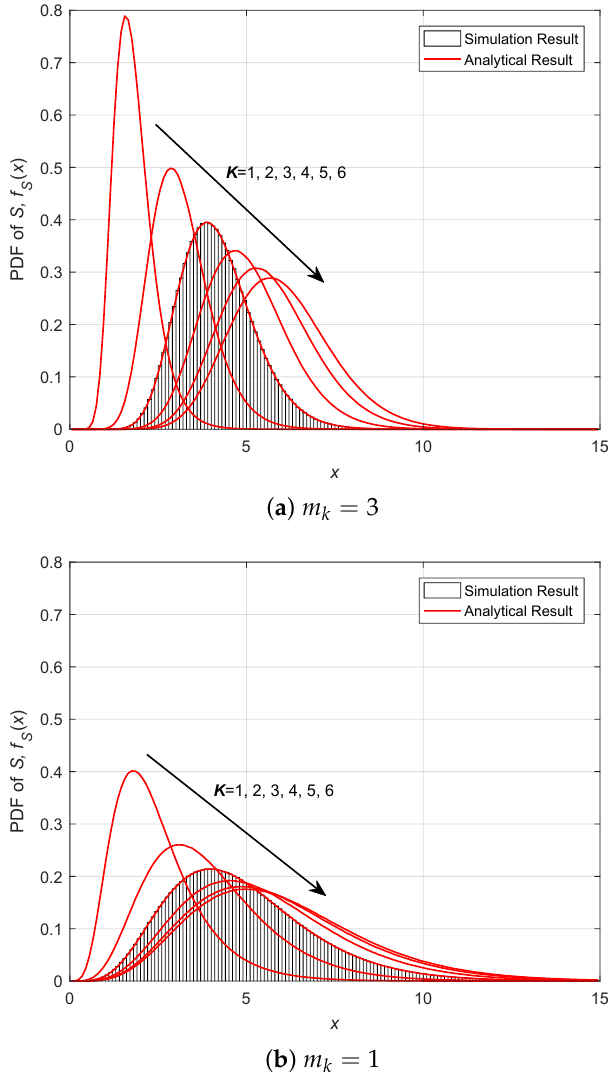
Figure 1. PDF of S , f S ( x ) , for various values of K when M = 6 and γ =